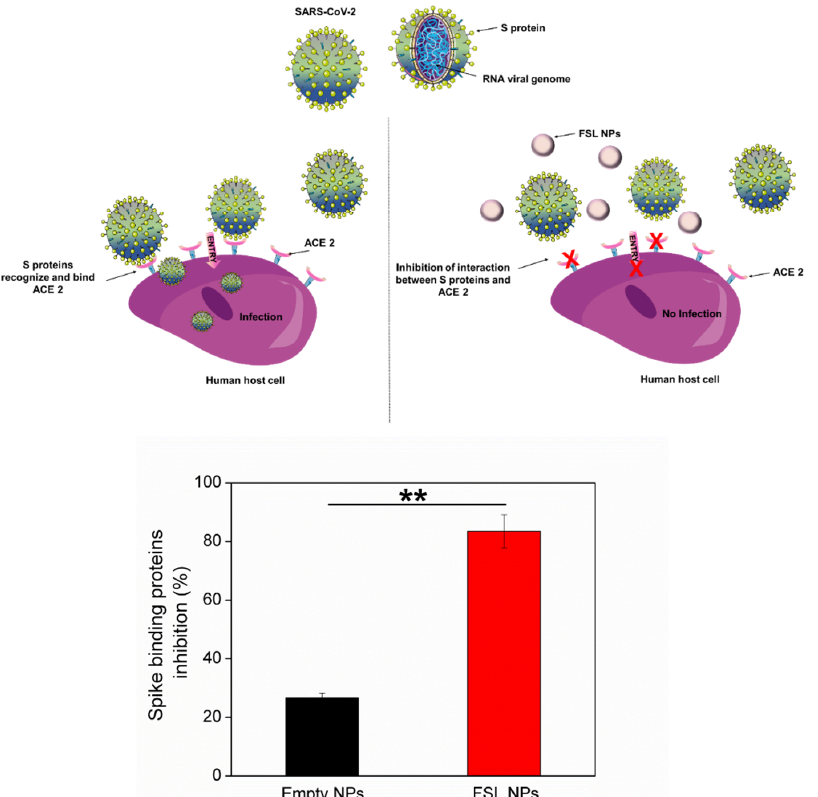
Figure 6. Schematic representation of interaction between the spike-binding proteins of SARS-CoV-2 and the ACE2 receptor on the host cell, and its inhibition after exposure to empty and FSL NPs. Parts of the figure were created using templates from Servier Medical Art (smart.servier.com (accessed on 18 June 2022)). Stars represent the statistical differences between empty and FSL NP inhibition of the spike protein binding interaction and the ACE2 receptor ( p < 0.001).